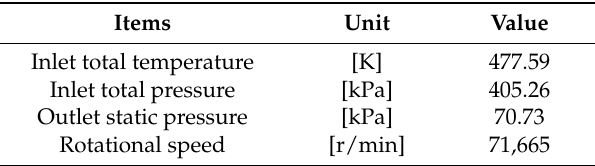
Table 5. Design condition of the test